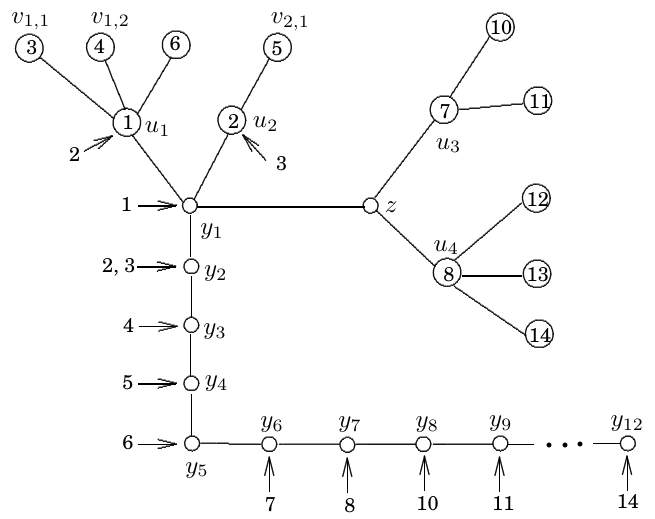
Figure 4: The graph G in the proof of Case 2 of Theorem